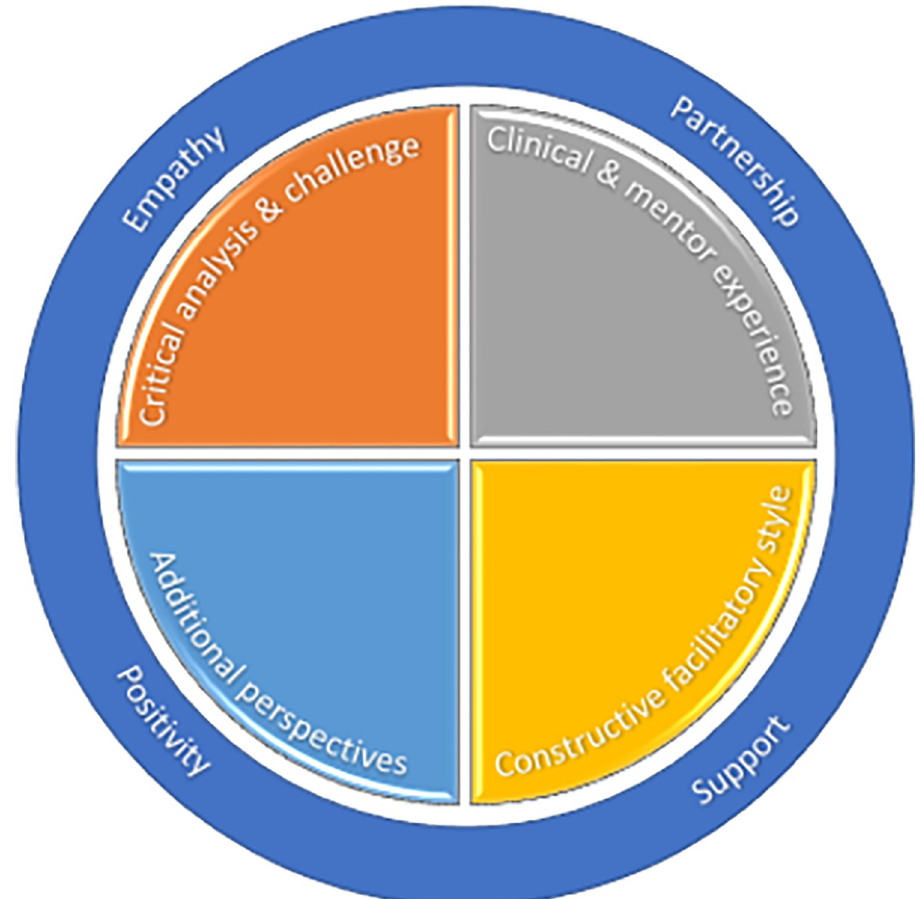
Fig 2. Emerging model of MCP–mentor